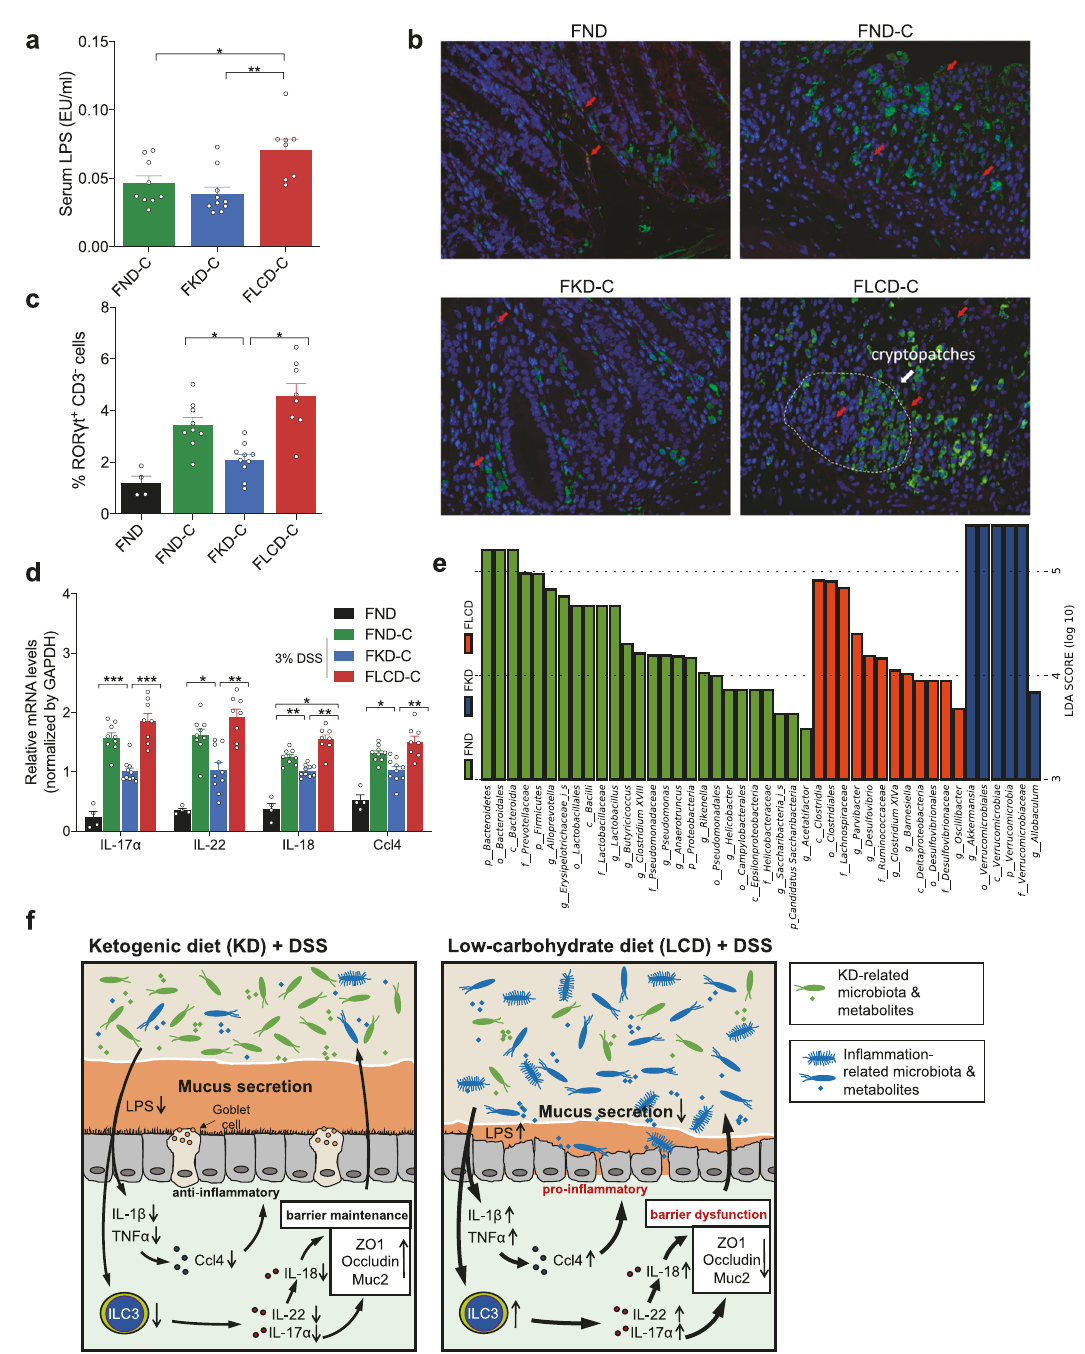
Fig. 7 Effects of FMT from KD- and LCD-fed mice on mucosal in fl ammation and immunity in colitis-induced germ-free mice. a Serum LPS levels detected by end-point chromogenic tachypleus amebocyte lysate in DSS-induced colitis germ-free mice after FMT from mice fed with KD (FKD-C), LCD (FLCD-C), or ND (FND-C). b Representative immuno fl uorescence images of ROR γ t + CD3 − ILC3 cells in colon tissues (original magni fi cation ×400). Green: positive staining of ROR γ t; Red arrows: positive staining of CD3. c Percentage of ROR γ t + CD3 − ILC3 cells in colonic sections. d Quantitative RT-PCR con fi rming changes in IL-17 α , IL-18, IL-22, and Ccl4 expression. e Histogram of linear discriminant analysis scores for differentially abundant bacteria in each group (p: Phylum, c: Class, o- Order, f: Family, g: Genus). f Schematic summary for the proposed role of KD (left) and LCD (right) in colitis. * p < 0.05; ** p < 0.01; *** p < 0.001. (FKD-C, n = 10, FLCD-C, n = 8; FND-C, n = 9; FND, n = 4). Results are expressed as mean ± SEM ( a , c , d ). KD ketogenic diet, LCD low-carbohydrate diet, ND normal diet, DSS dextran sulfate sodium, in KD suggests a more intensi fi ed direct interaction between such as activated bacterial motility and LPS biosynthesis path- bacteria and intestinal epithelial cells. ways, which are common in IBD animal models and accom- In general, our global nontargeted metabolomics analysis of fecal panied by changes in intestinal barrier function. 20,21 samples from the KD, LCD, and ND groups yielded unique and Over-represented bacterial invasion of epithelial cells function